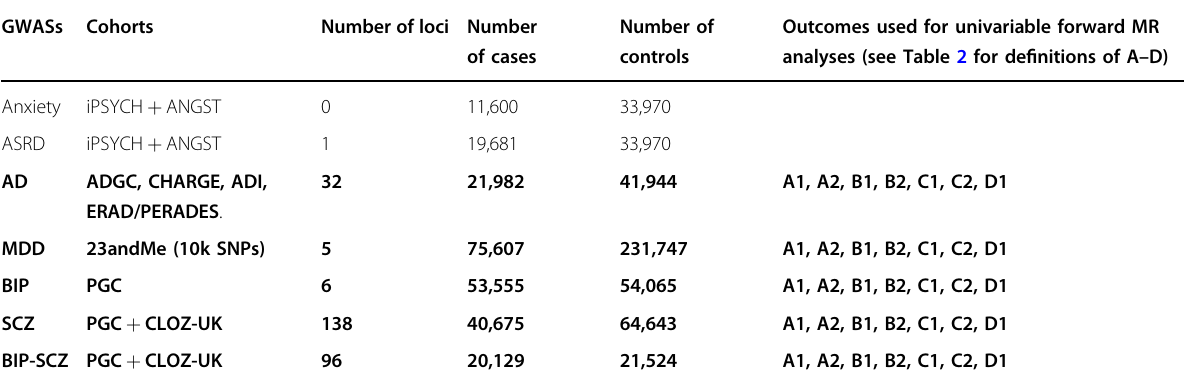
Table 1 GWASs of (neuro)psychiatric disorders used for the current study and outcomes used for the univariable forward MR